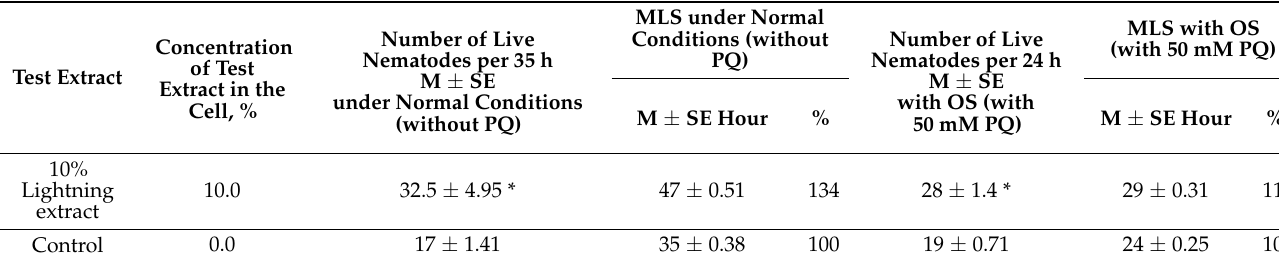
Table 3. MLS of the nematode C. elegans .